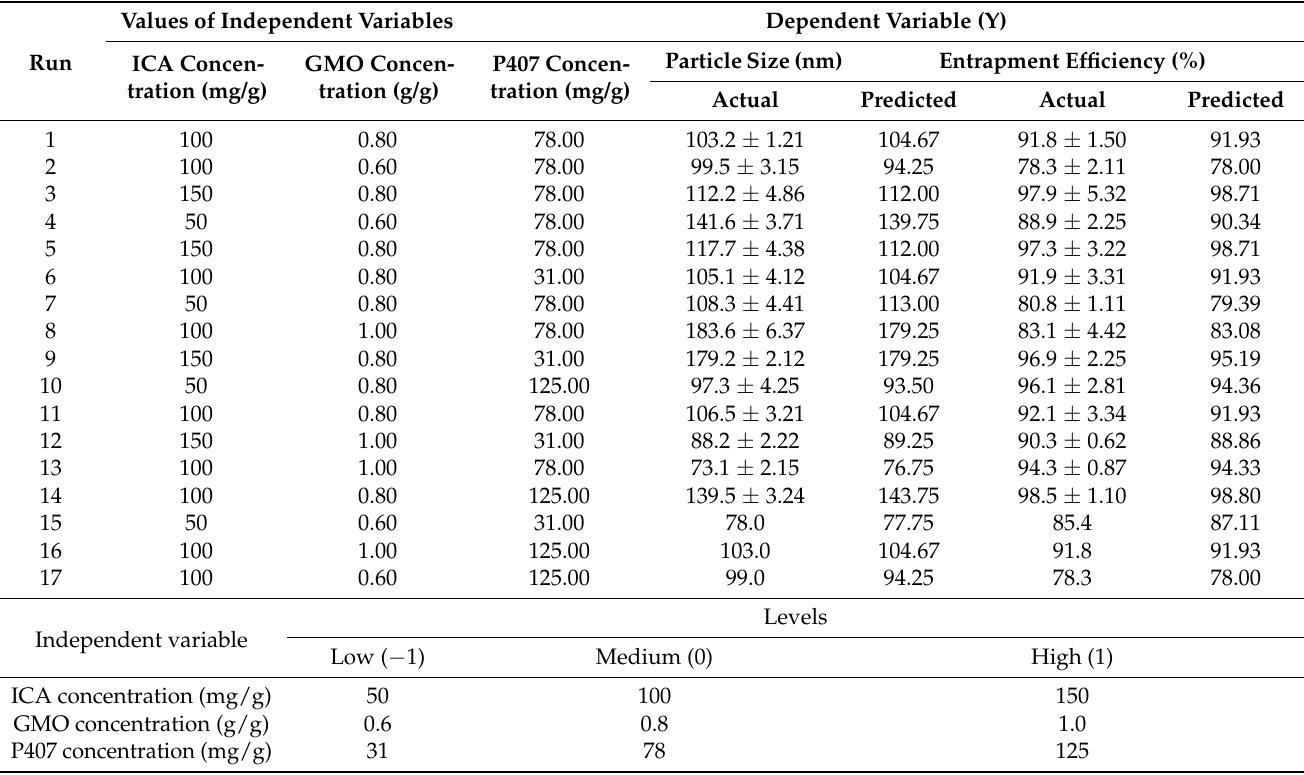
Table 1. Experimental runs according to the Box–Behnken statistical design: The independent variables and dependent variables with the levels of the independent variables, ICA concentration, GMO concentration. and P 407